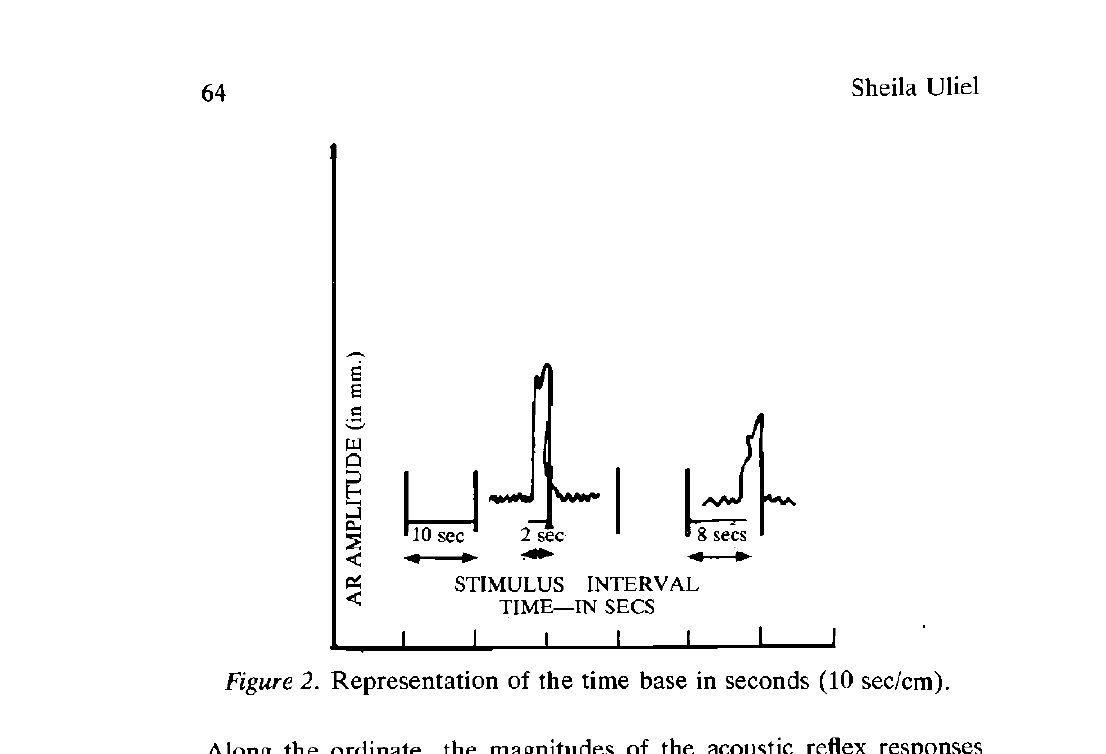
Figure 2. Representation of the time base in seconds (10